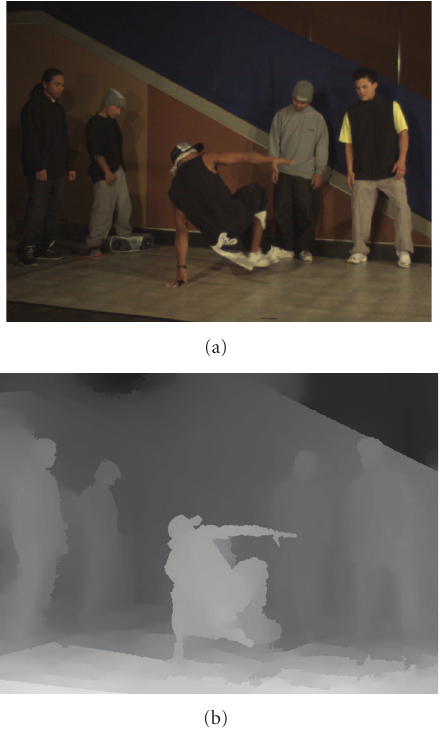
Figure 8: Breakdance sequence: (a) sample frame of the sequence and (b) sample depth map.